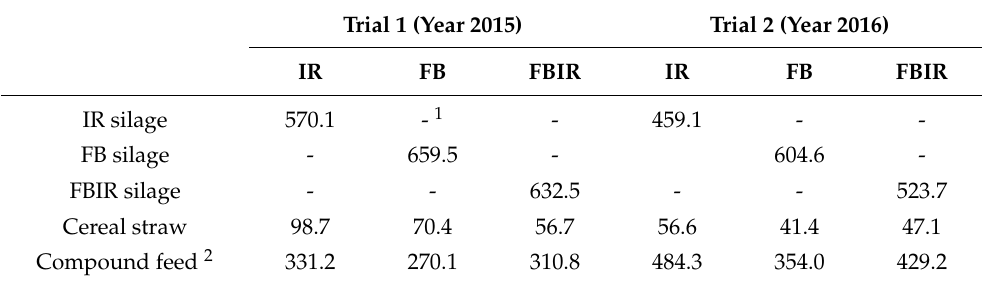
Table 1. Ingredient composition (g kg − 1 DM) of the total mixed rations (TMR) used in feeding